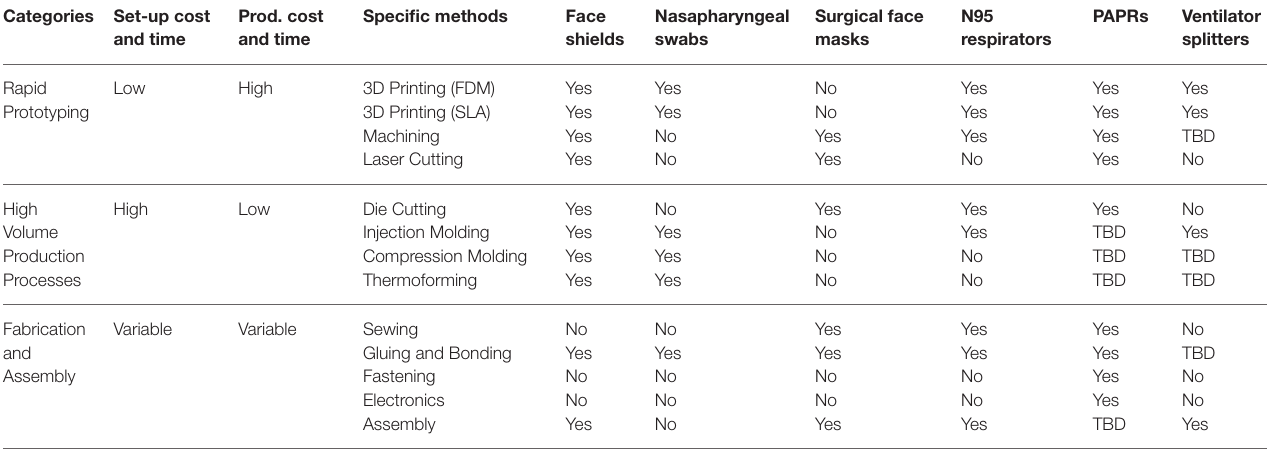
TABLE 1 | Prototyping and manufacturing methods applicable to production of five medical devices, based on Open Source COVID-19 Medical Supply Guide (41). Categories Set-up cost and